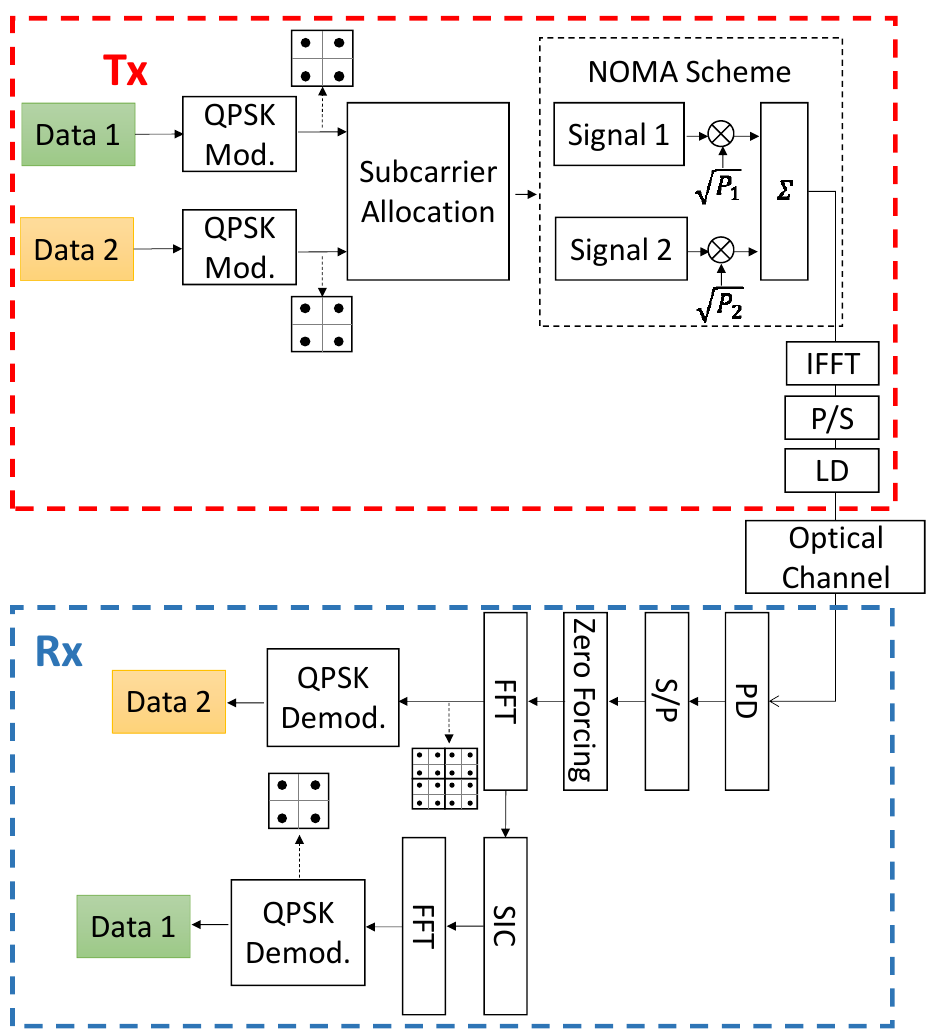
Figure 1. Principle of encoding and decoding of the proposed PowDM VLC system. QPSK: quad- rature phase shift keying; IFFT: inverse fast Fourier transformation; P/S: parallel-to-serial; LD: laser diode; PD: photodiode; S/P: serial-to-parallel; SIC: successive Interference cancelation.